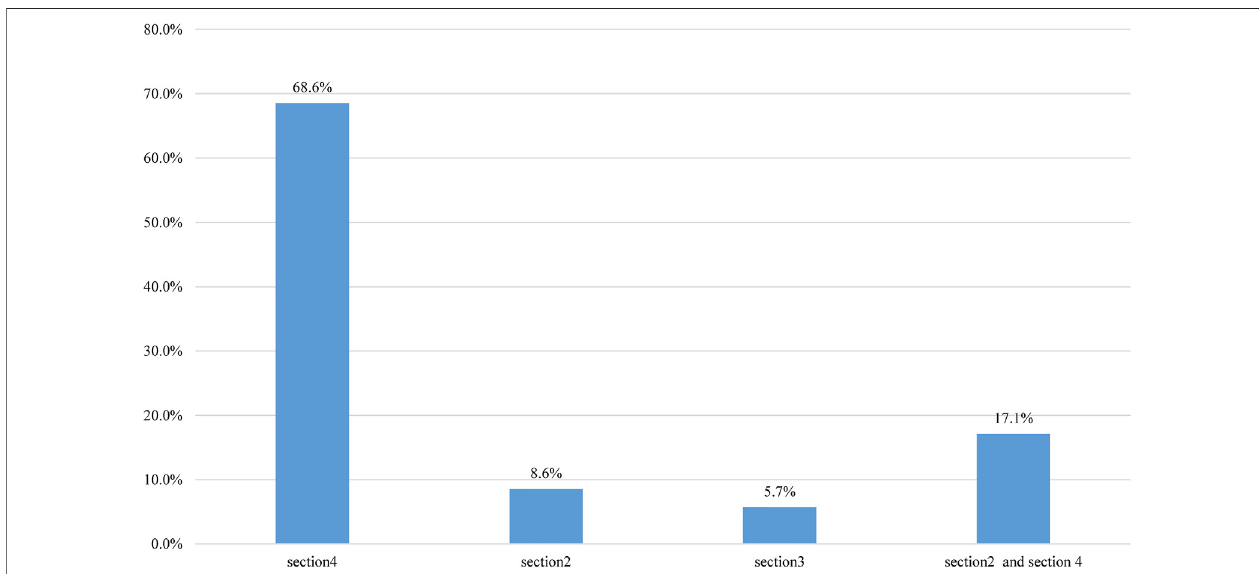
FIGURE 2 | The reasons for classi fi cation discordance after consensus reason. The reasons were summarized according to the categories of evidence submitted by laboratories for the 35 CNVs, with classi fi cation discordance possibly impacting medical management. The column “ section 2 + section 4 ” indicates that the discordance is attributable to usage differences in both sections 4 and